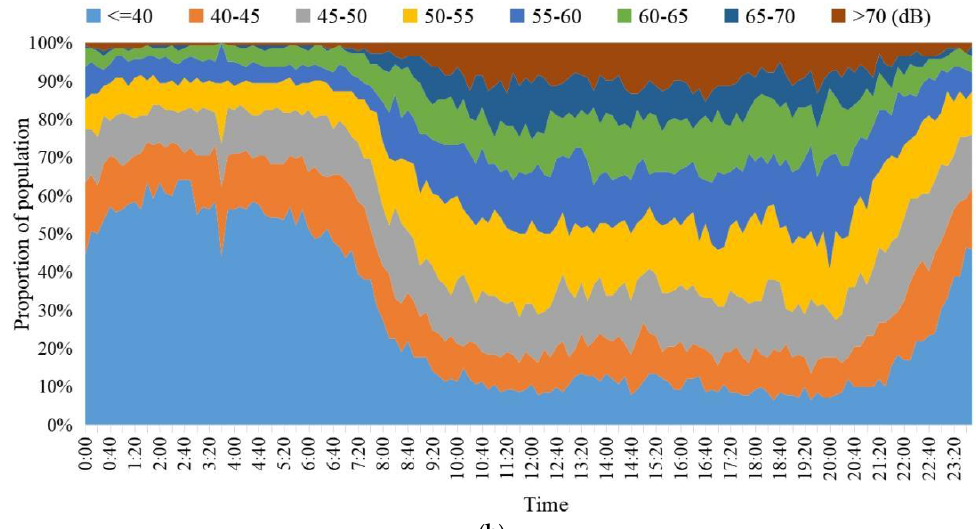
Figure 6. The 24 h noise exposure of 142 residents on workdays and weekends. ( a ) Workday; ( b ) weekend.